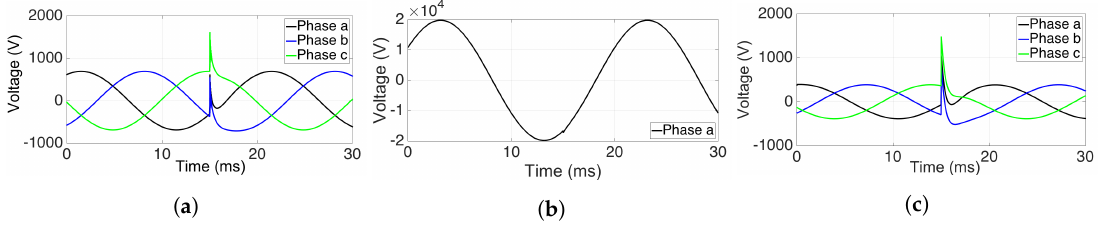
Figure 10. Impact of increased vertical conductor on transient overvoltages. ( a ) LV side of the main transformer; ( b ) HV side of the main transformer from node to ground; ( c ) control